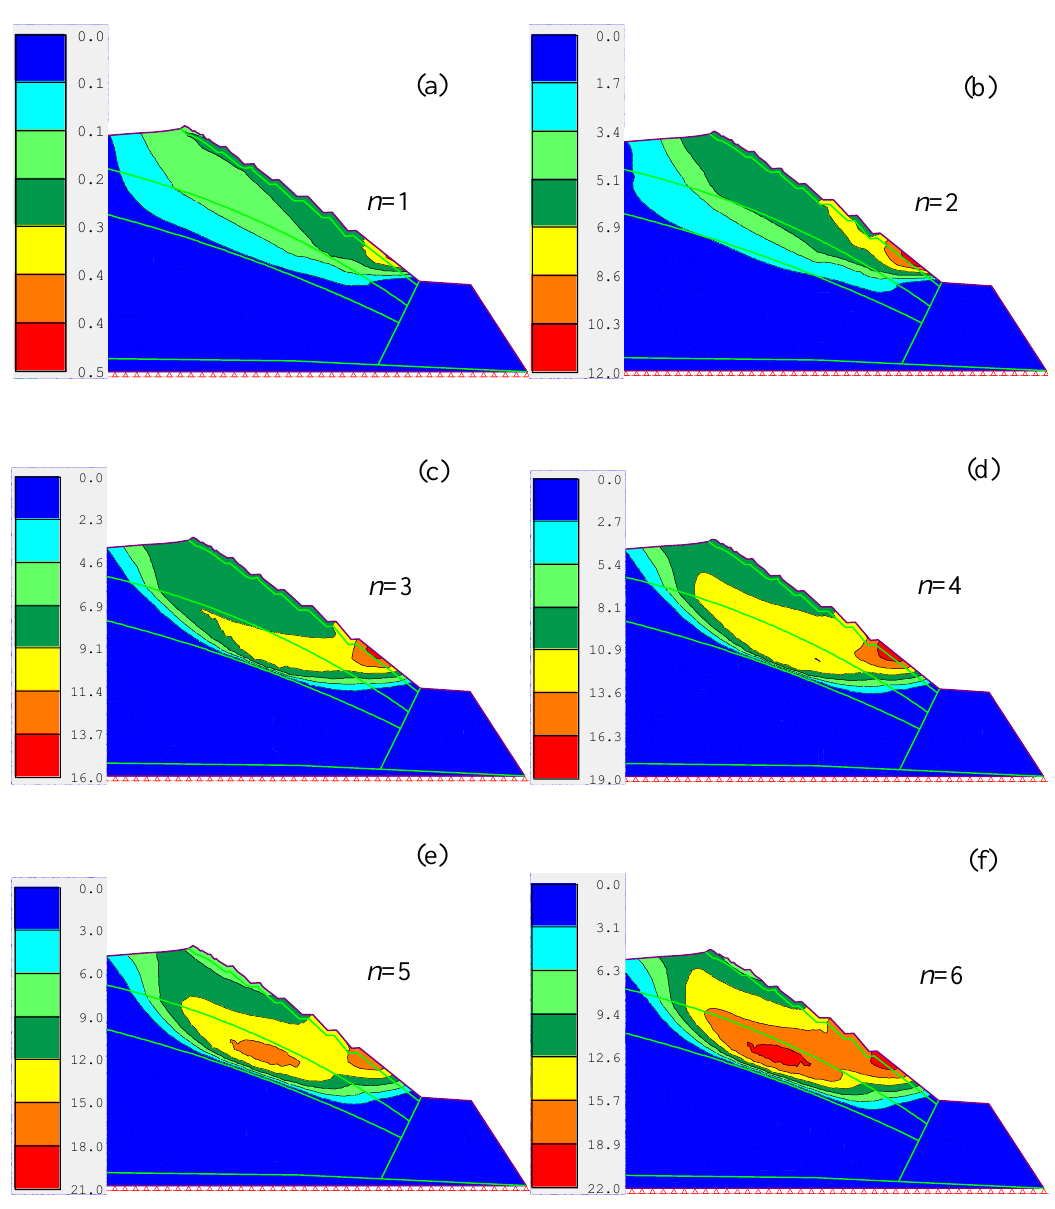
Figure 7. Diagram of displacement after different DW cycles ( n is the number of DW cycles). ( a ) n = 1; ( b ) n = 2; ( c ) n = 3; ( d ) n = 4; ( e ) n = 5; ( f ) n = 5.